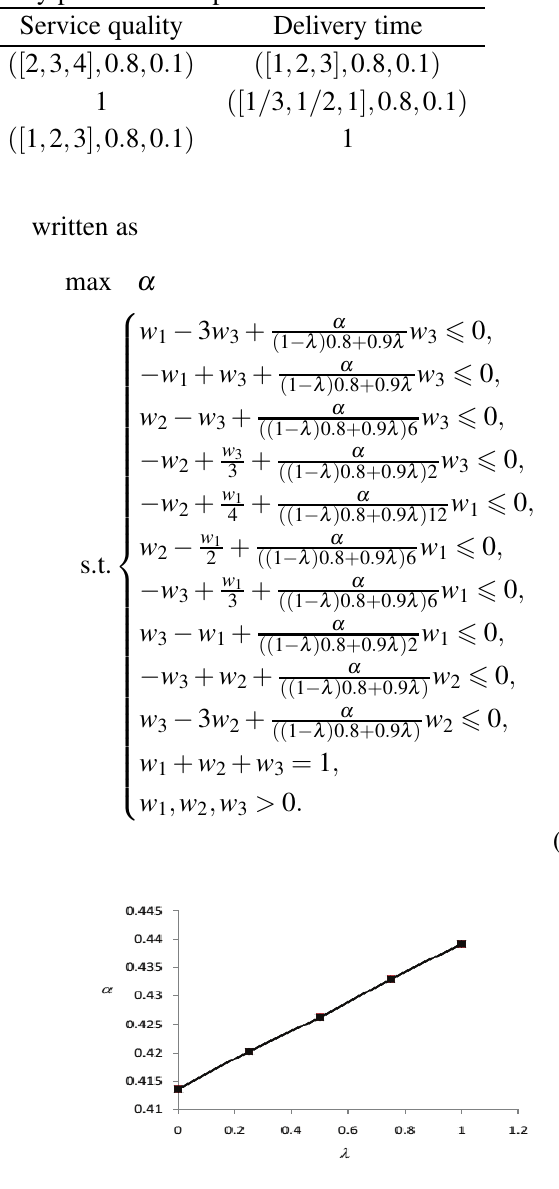
Fig. 2. Changes in priority vector and satisfaction level with respect to parameter λ